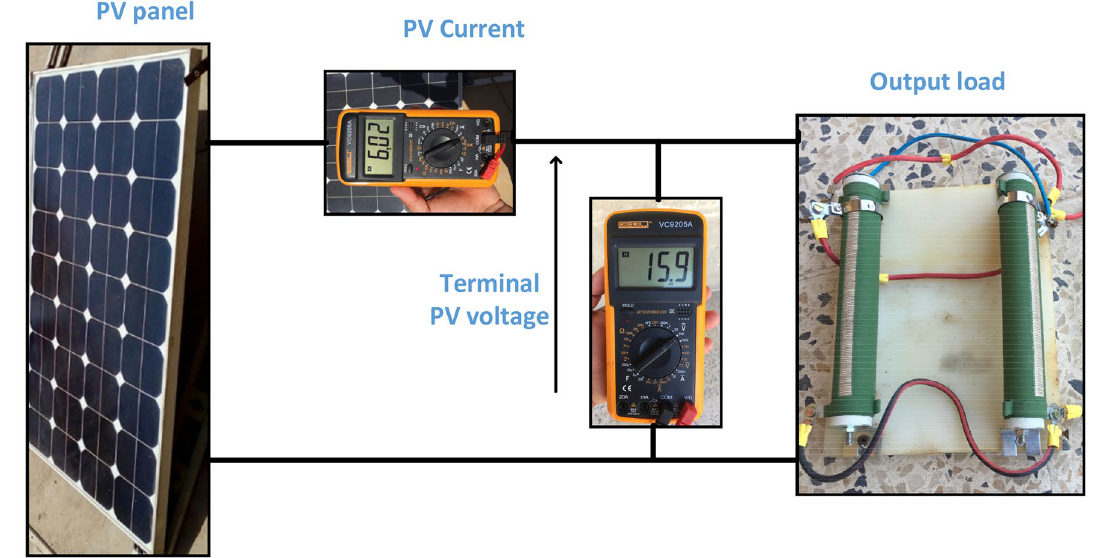
Figure 14. Experimental components of the proposed PV system.